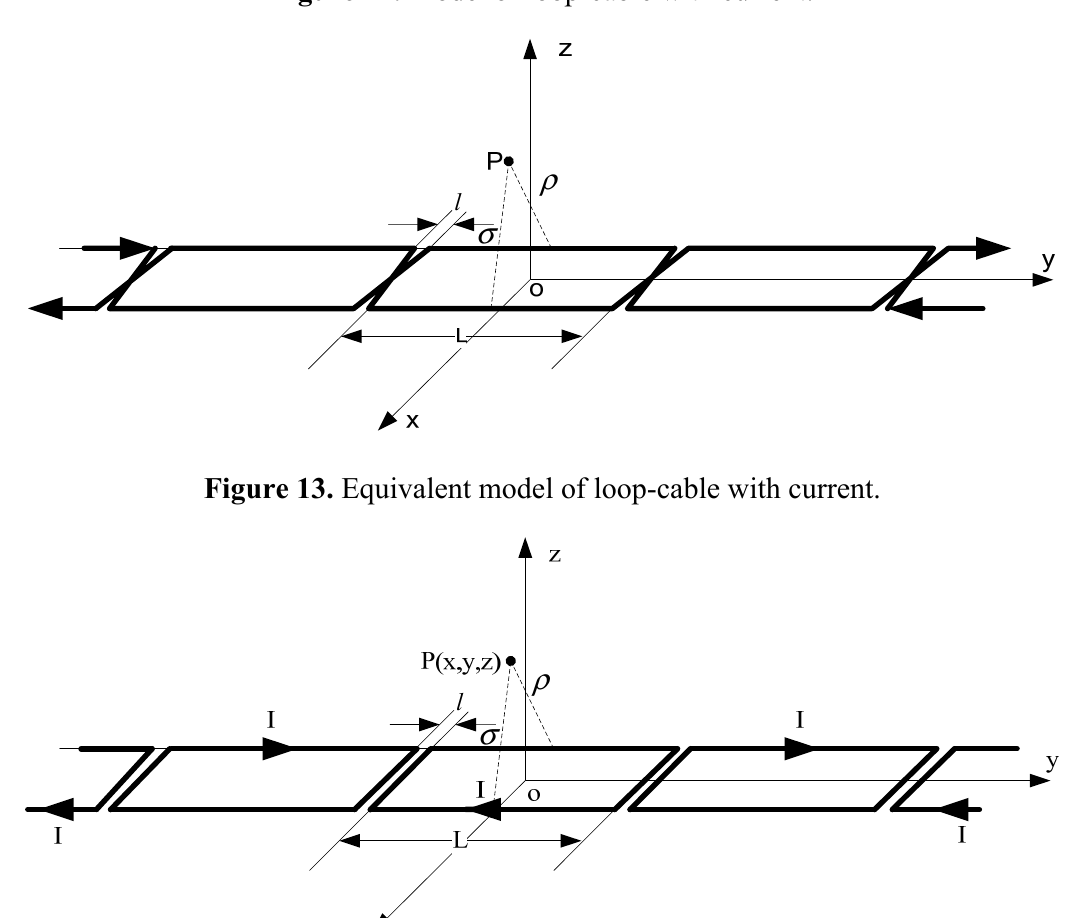
Figure 12. Model of loop-cable with current.